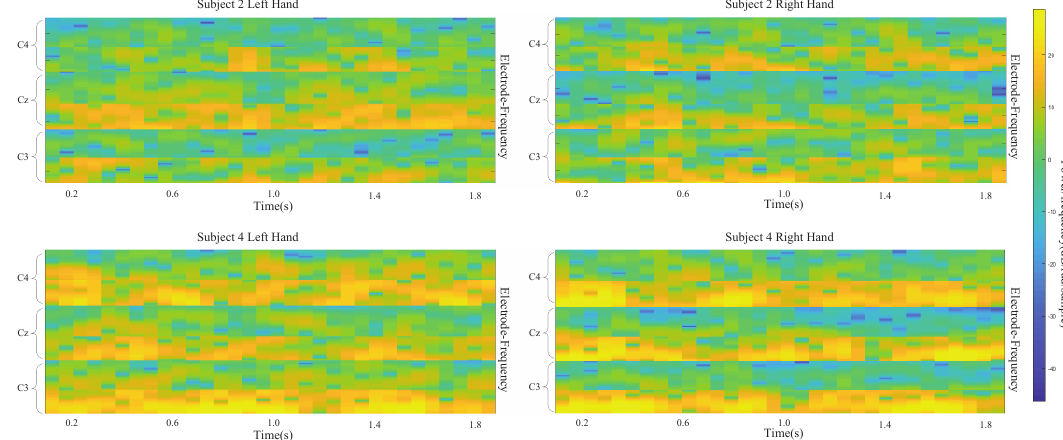
Figure 8. input images for left- and right-hand classes of subject 2 and subject